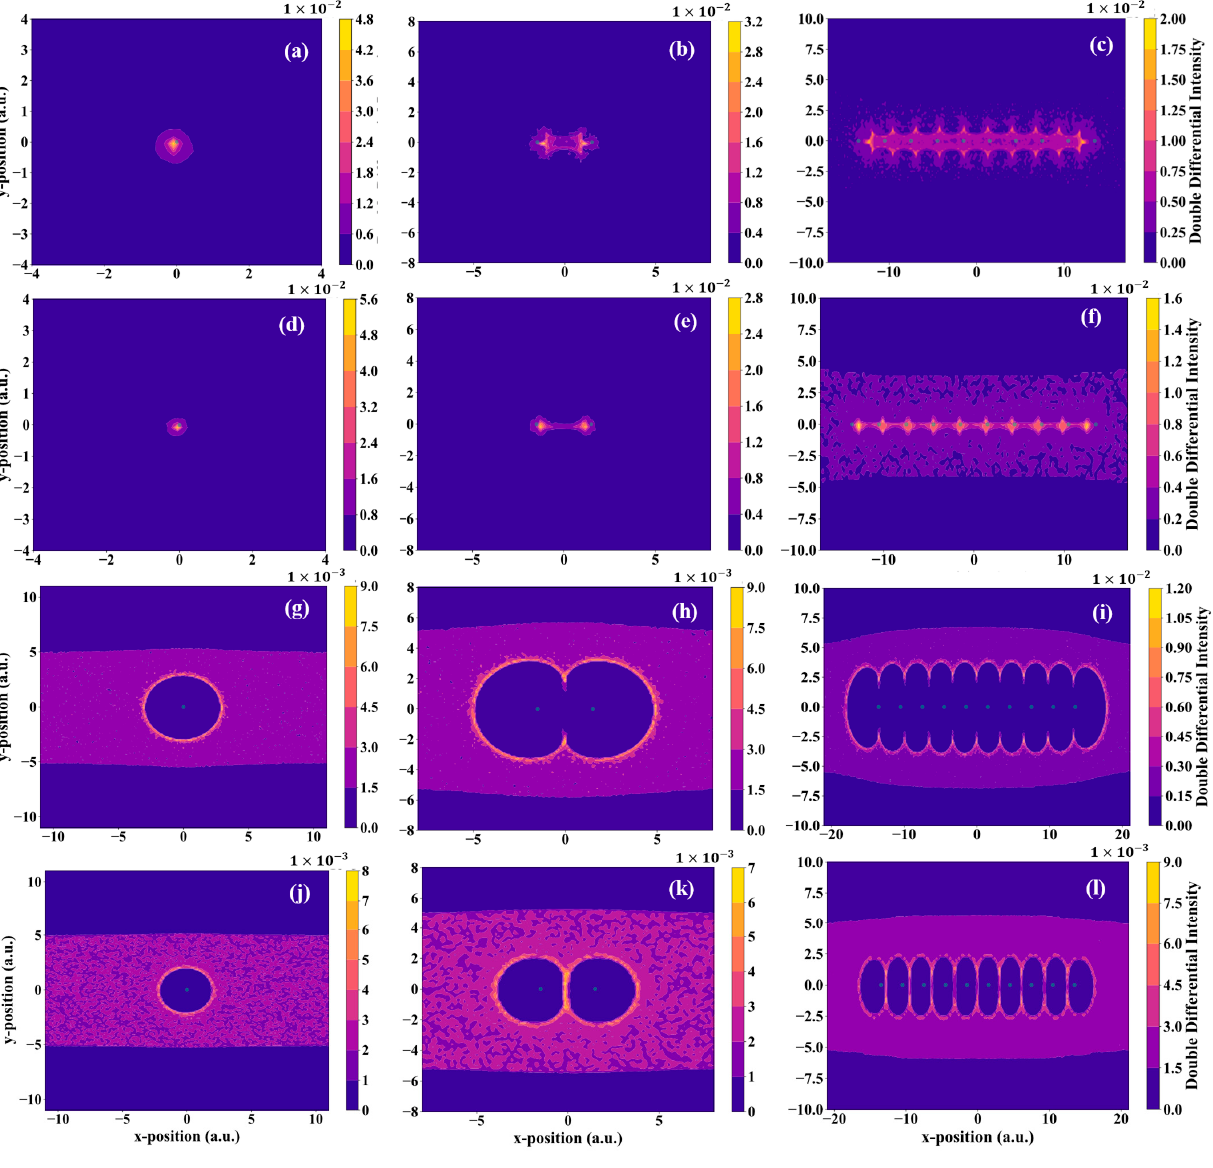
Figure 4. Double differential intensity distribution of projectiles at the two-dimensional detection plane, one-proton system with ( a ) 500 eV electrons, ( d ) 1000 eV electrons, ( g ) 500 eV positrons and ( j ) 1000 eV positrons; two-proton system with ( b ) 500 eV electrons, ( e ) 1000 eV electrons, ( h ) 500 eV positrons and ( k ) 1000 eV positrons; ten-proton system with ( c ) 500 eV electrons, ( f ) 1000 eV elec- trons, ( i ) 500 eV positrons and ( l ) 1000 eV positrons. The small green circles indicate the position of the protons.